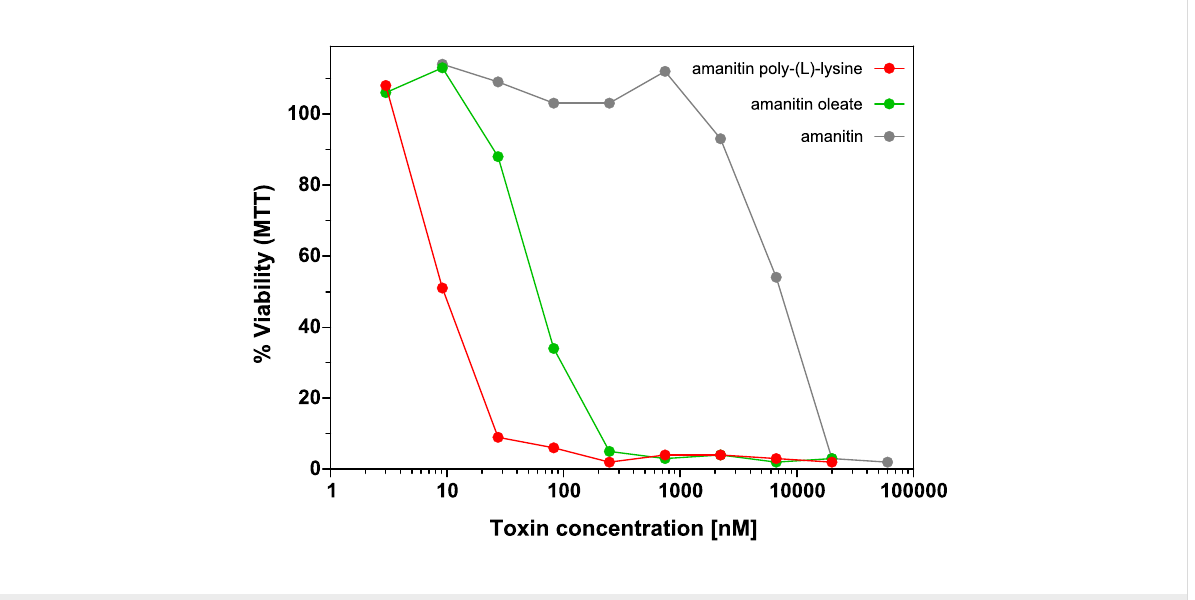
Figure 8: NIH 3T3 mouse fibroblasts were incubated with various concentrations of α -amanitin and amanitin derivatives. Cell viability was determined after 72 h incubation time by MTT assay.